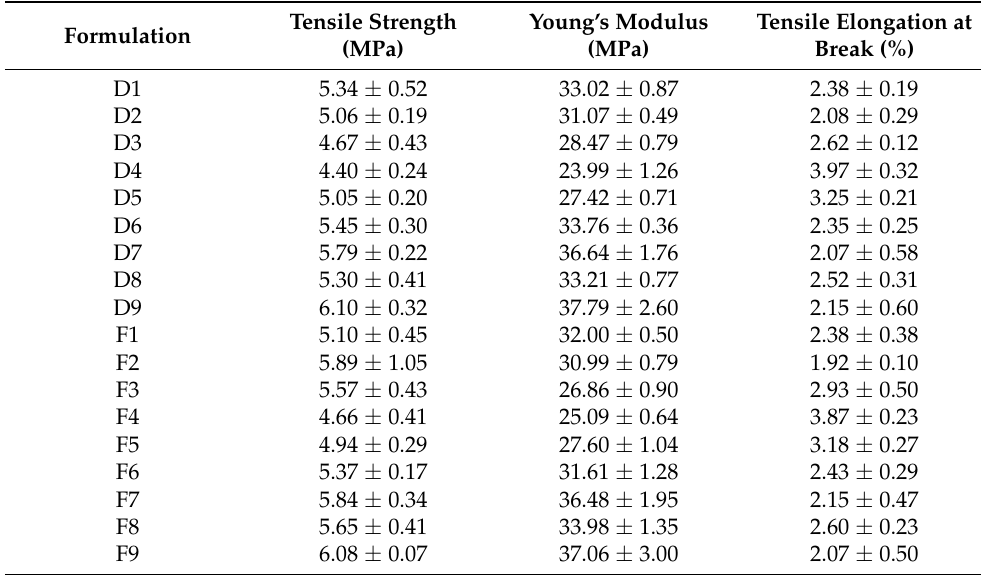
Table 4. The mechanical properties of the produced polymeric films. Tensile Strength Young’s Modulus Formulation (MPa)